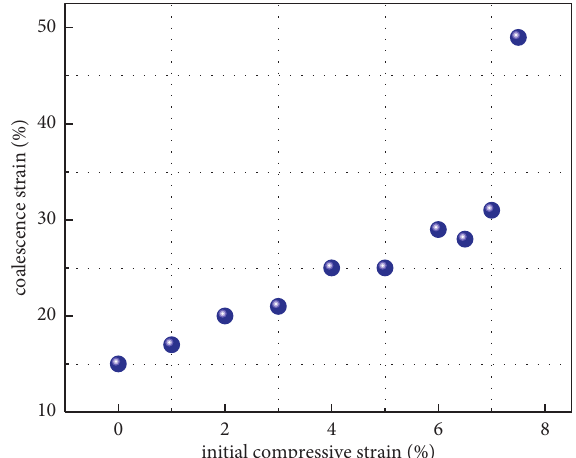
Figure 5: Relationship between the initial compressive strain and coalescence